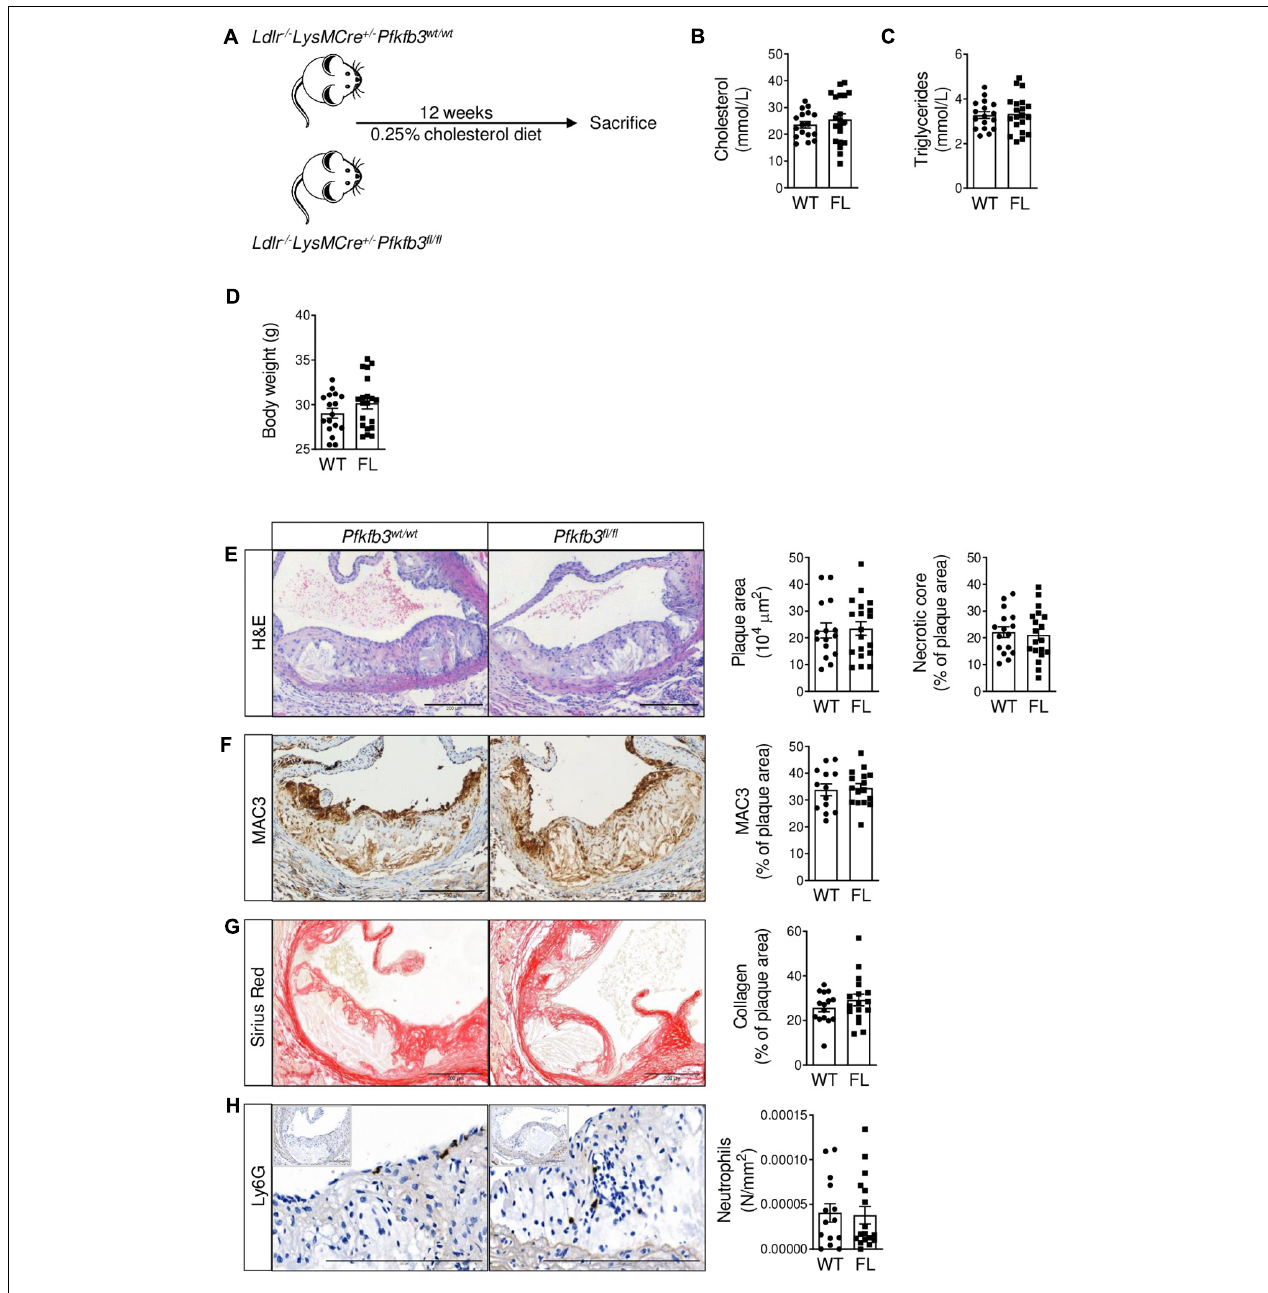
FIGURE 3 | No effect of partial myeloid Pfkfb3 disruption on advanced atherosclerotic lesions in aortic roots. (A) Setup of mouse experiment using Ldlr - / - LysMCre + / − Pfkfb3 fl / fl ( Pfkfb3 fl / fl , n = 20) and Ldlr - / - LysMCre + / − Pfkfb3 wt / wt ( Pfkfb3 wt / wt , n = 17) mice. (B) Cholesterol and (C) triglyceride levels in Pfkfb3 wt / wt (WT) and Pfkfb3 fl / fl (FL) plasma. (D) Body weight of Pfkfb3 wt / wt and Pfkfb3 fl / fl mice after 12 weeks of high cholesterol diet. (E) H&E, (F) MAC3, (G) Sirius Red and (H) Ly6G staining in Pfkfb3 wt / wt and Pfkfb3 fl / fl AR lesions and corresponding quantifications. The graphs represent mean ± SEM. Scale bars 200 µ m. Data in B and H were analyzed using Mann-Whitney U test. Data in C–G were analyzed using Student’s t